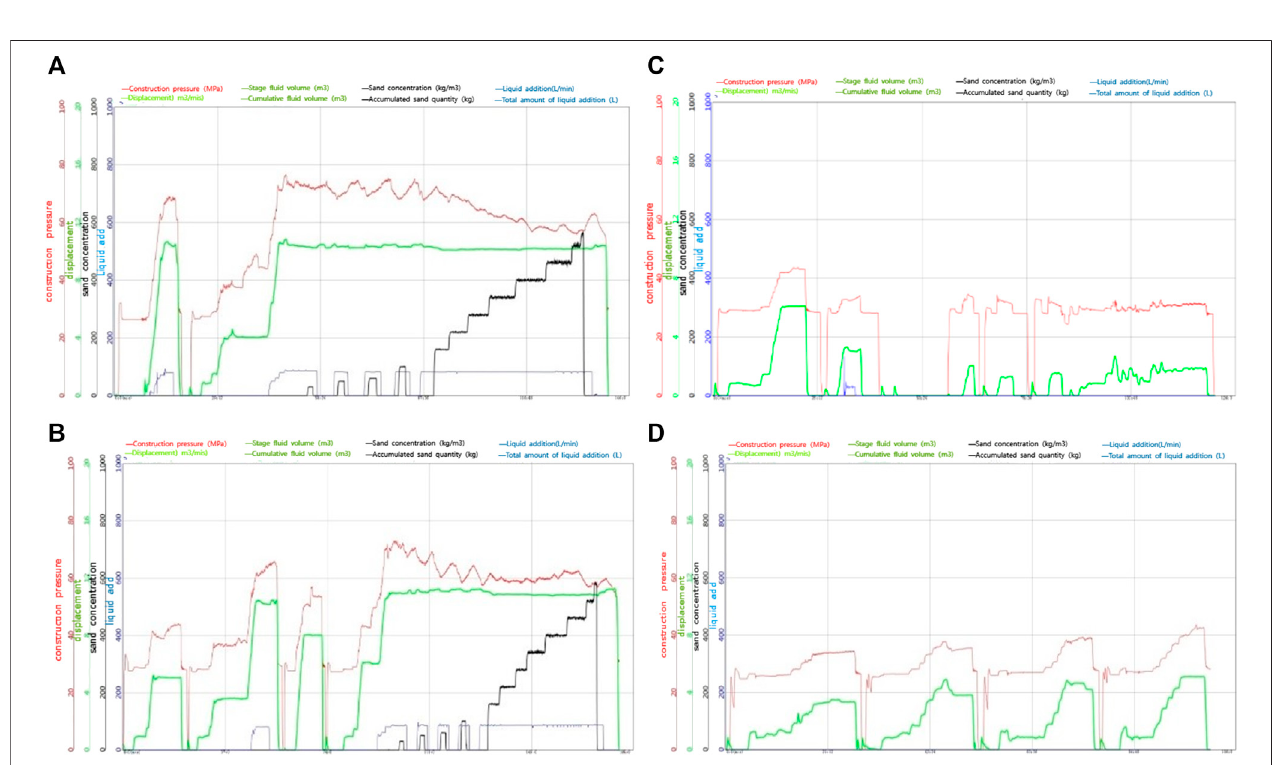
FIGURE6|(A) First-stagefracturingoperationgraphofthenewfractureinwellM7; (B) Second-stagefracturingoperationgraphofthenewfractureinwellM7; (C) First construction graph of the third stage fracturing of the new fracture in well M7; (D) Second construction graph of the third stage fracturing of the new fracture in well